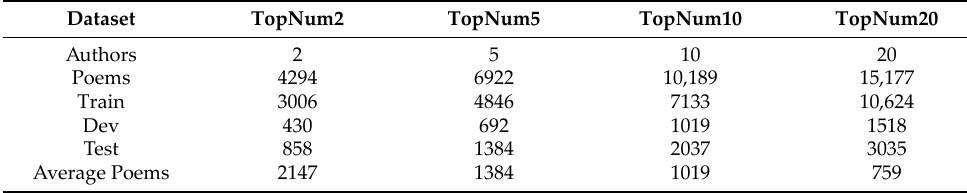
Table 4. Statistics of the Top Num